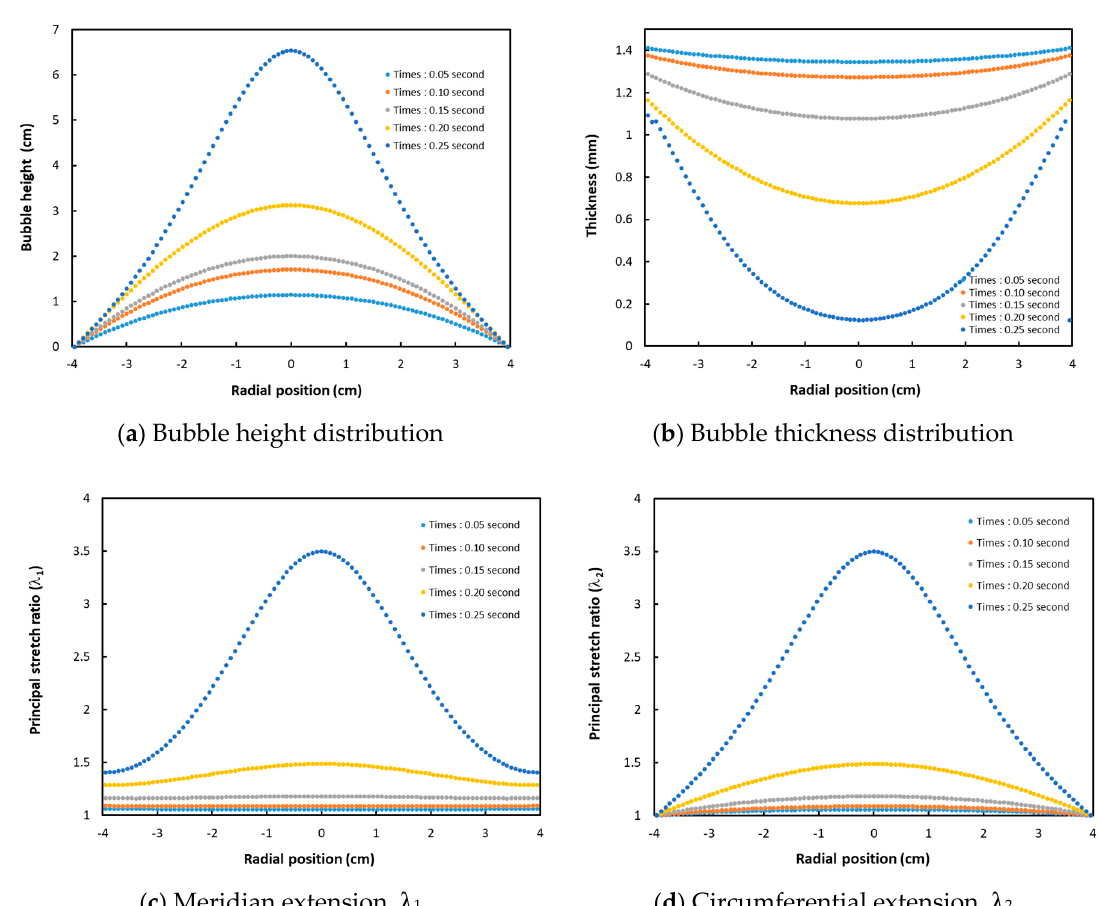
Figure 6. Geometrical PMSQ–HDPE membrane according to Christensen’s model at 0.05, 0.10, 0.15, 0.20, and 0.25 s: ( a ) Bubble height, ( b ) Bubble thickness, ( c ) Stretch ration λ 1 and ( d ) Stretch ration λ 2 .